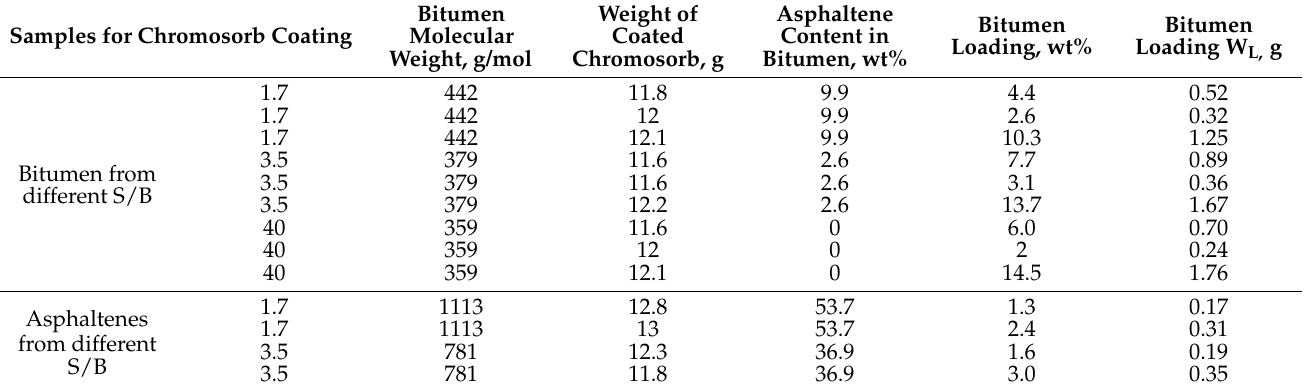
Table 2. The properties of different Bitumen/Asphaltenes of different